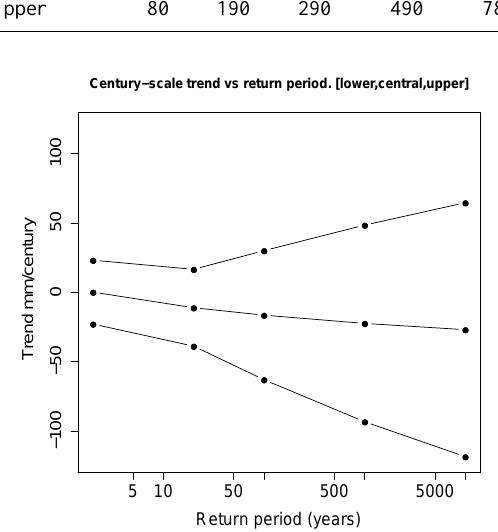
Figure 8. Projected century-scale trends in skew surge for five re- turn periods due to storminess changes only (i.e. excluding mean sea level change; millimetres per century). Central, lower and upper estimates are shown.